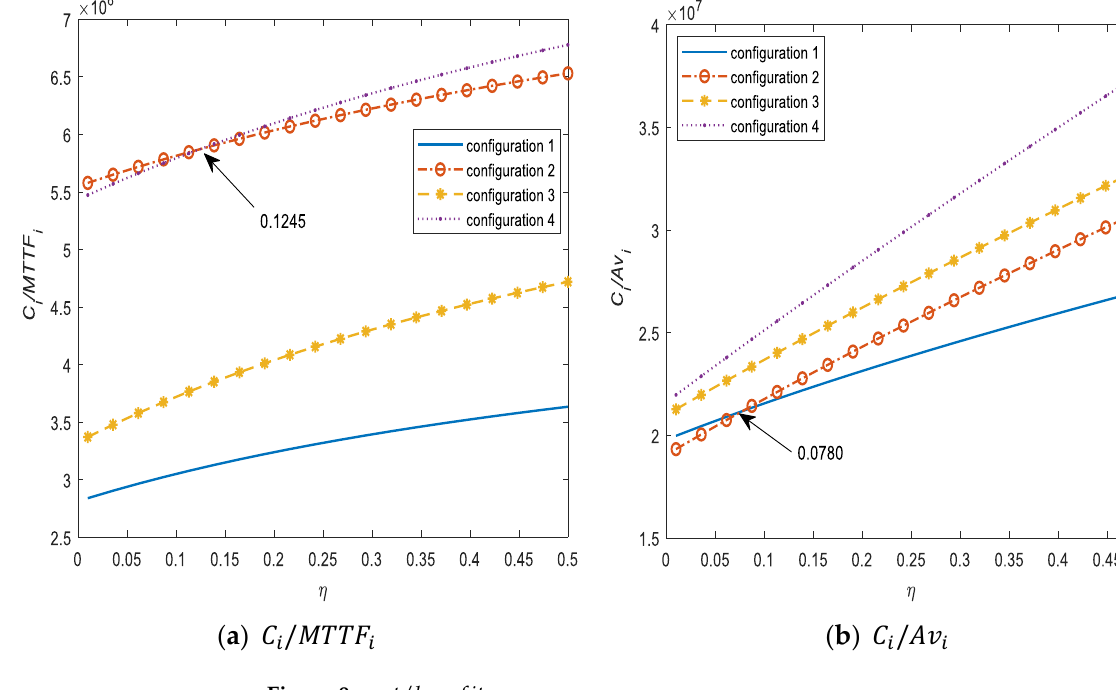
Figure 9. 𝑐𝑜𝑠𝑡/𝑏𝑒𝑛𝑒𝑓𝑖𝑡 versus η . Figure 9. cost / benefit versus η .